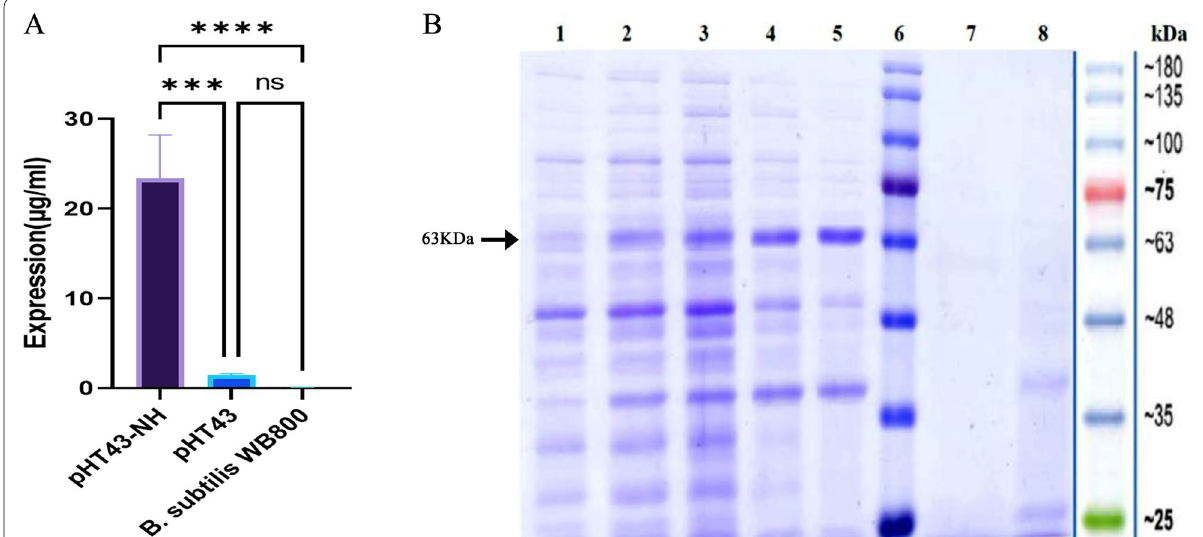
Fig. 6 Evaluation of recombinant protein expression in B. subtilis . A Summary of the normalized quantities of expression proteins in three bacterial groups. One-way analysis of variance (ANOVA) by Tukey’s method showed that in level P 0.05, the observed difference in pHT43_NH expression ≤ IPTG-induced pHT43 and the B. subtilis WB600 groups is statistically significant, whereas there was no statistically significant relationship between pHT43 and B.subtilis WB600. B Investigation of expression and secretion of recombinant HN protein (63KDa) in culture medium with acrylamide gel 12%. Column 1: expression before induction. Columns 2 to 5: gradual increase in the expression from 1 to 8 h after induction. Column 6: molecular weight (#SL7001-Sinaclon, Iran). Column 7: lack of protein secretion in the culture medium before induction. Column 8: lack of recombinant protein secretion in bacterial cells containing plasmid without HN genes